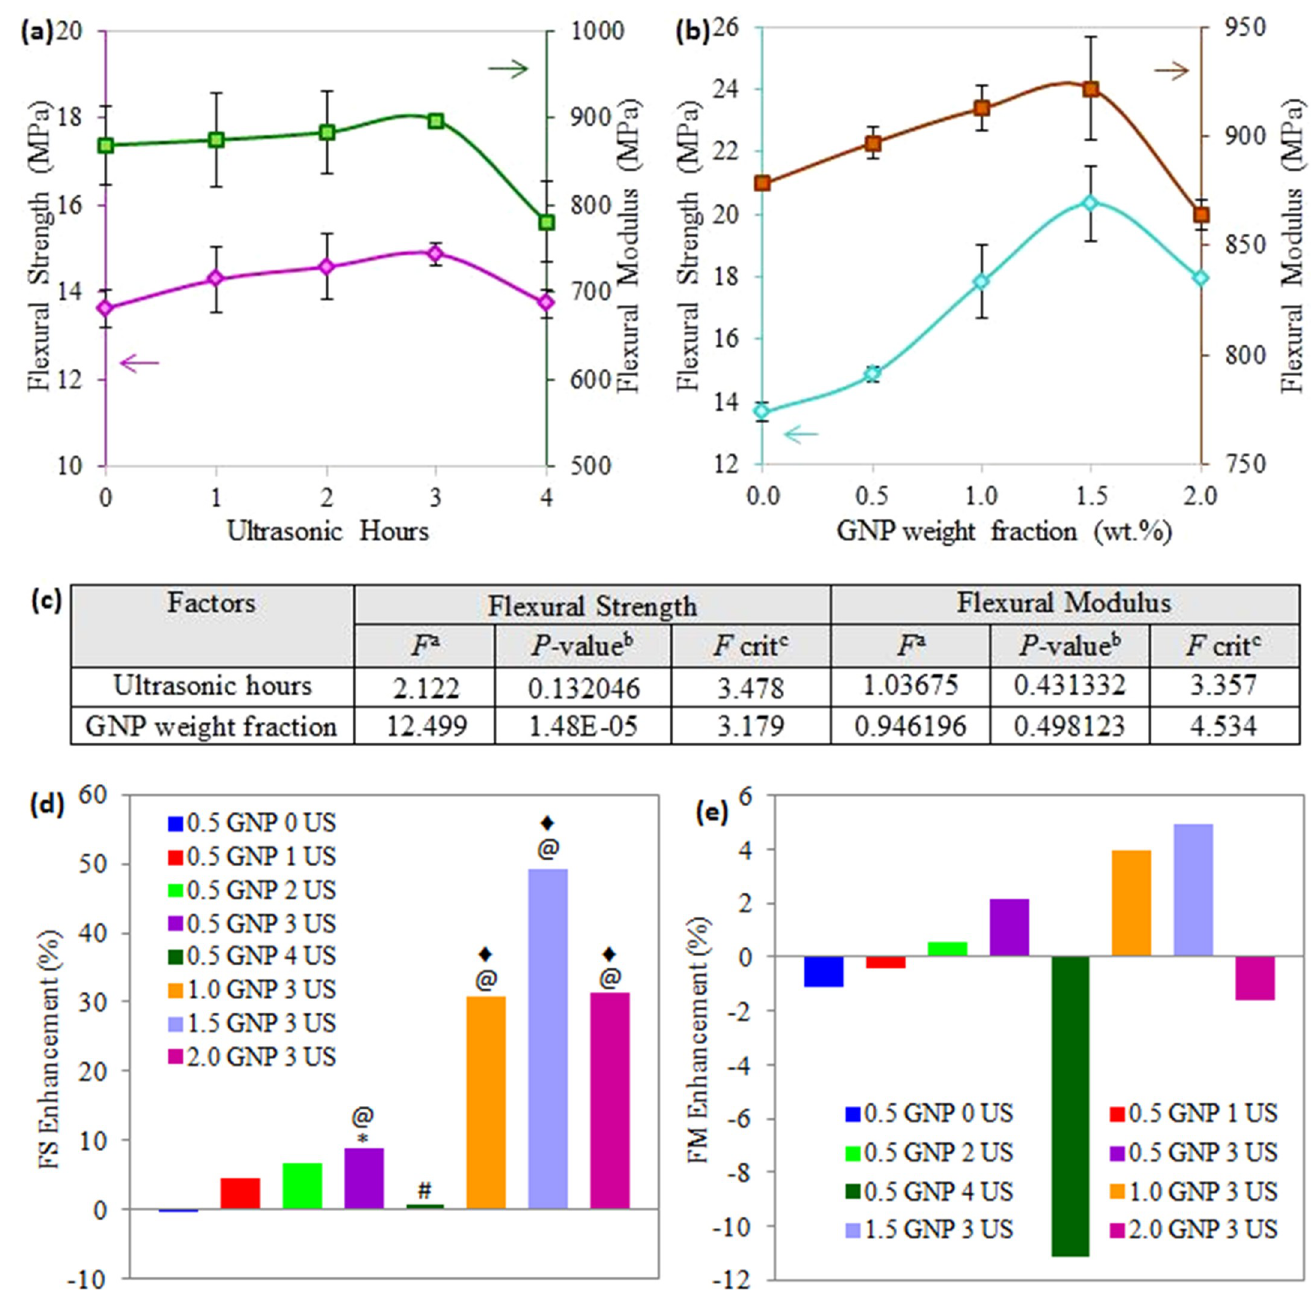
Fig 2. Flexural strength (FS) and flexural modulus (FM) of TPNR/GNP composites (a) treated with different ultrasonic (US) hours, (b) at various filler weight fractions, (c) ANOVA analysis for both factors in flexural properties, (d) FS enhancement and (e) YM enhancement of investigated composites compared with pure TPNR. Note: a F ratio = mean between groups variance/ mean within group variance; b Probability from 0 to 1; c critical F -value based on F distribution. Groups with a significant difference (p < 0.05) compared to (i) TPNR/GNP composite without US assistance (0 hour) and assisted with 3 hours US are indicated by � and # respectively; (ii) TPNR composites without GNP and incorporated with 0.5 wt.% GNP are indicated by @ and ♦ symbols,